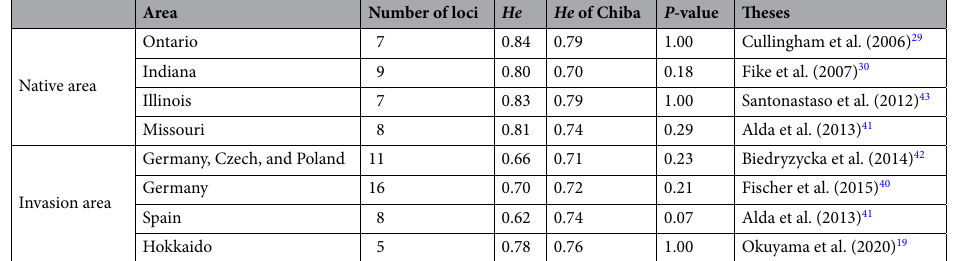
Table 4. The comparison results of the genetic diversity for raccoons between Chiba prefecture, Japan and other areas. Number of loci the number of loci that we used for comparison, He mean of expected heterozygosity, P- value The P-value that was calculated a result of sign test.